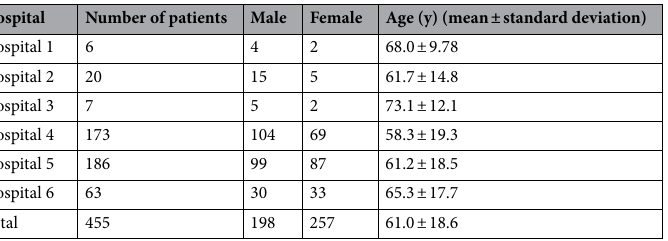
Table 2. Patients’ characteristics in the COVID private dataset. COVID private private dataset collected from six